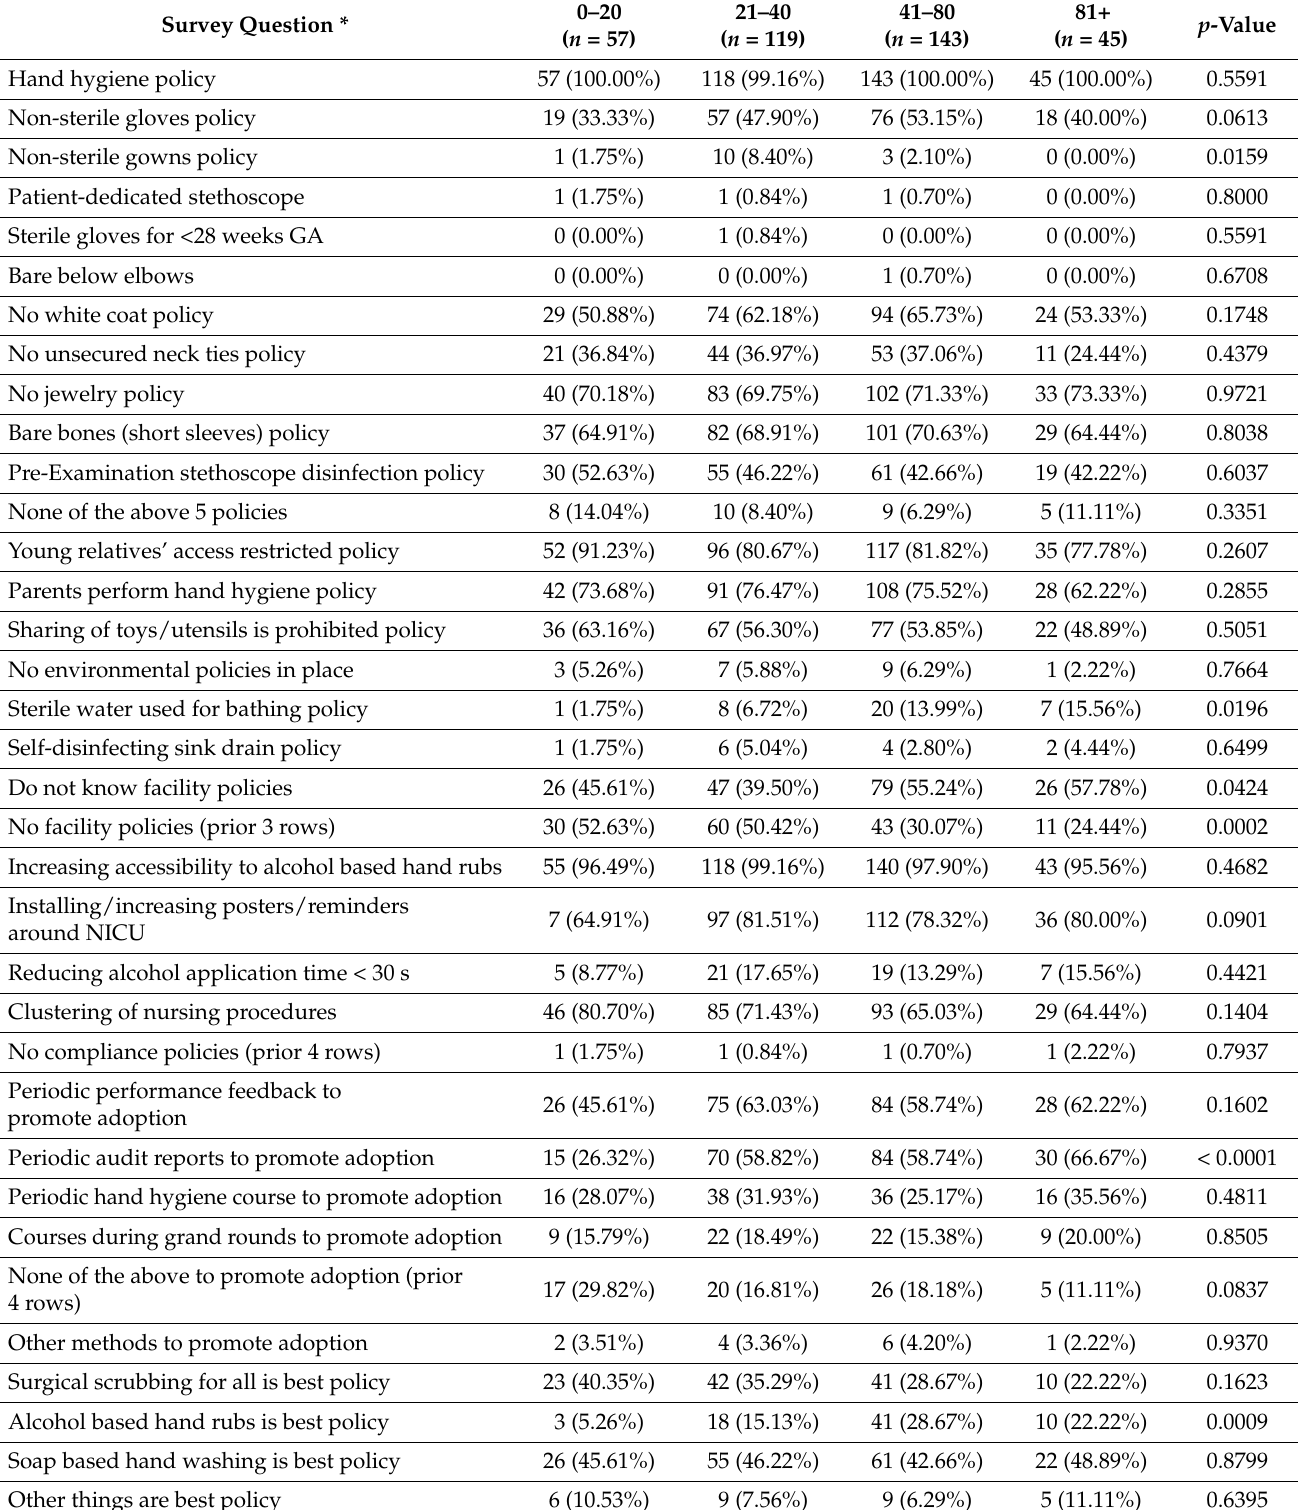
Table 2. Survey Results, Stratified by NICU Bed